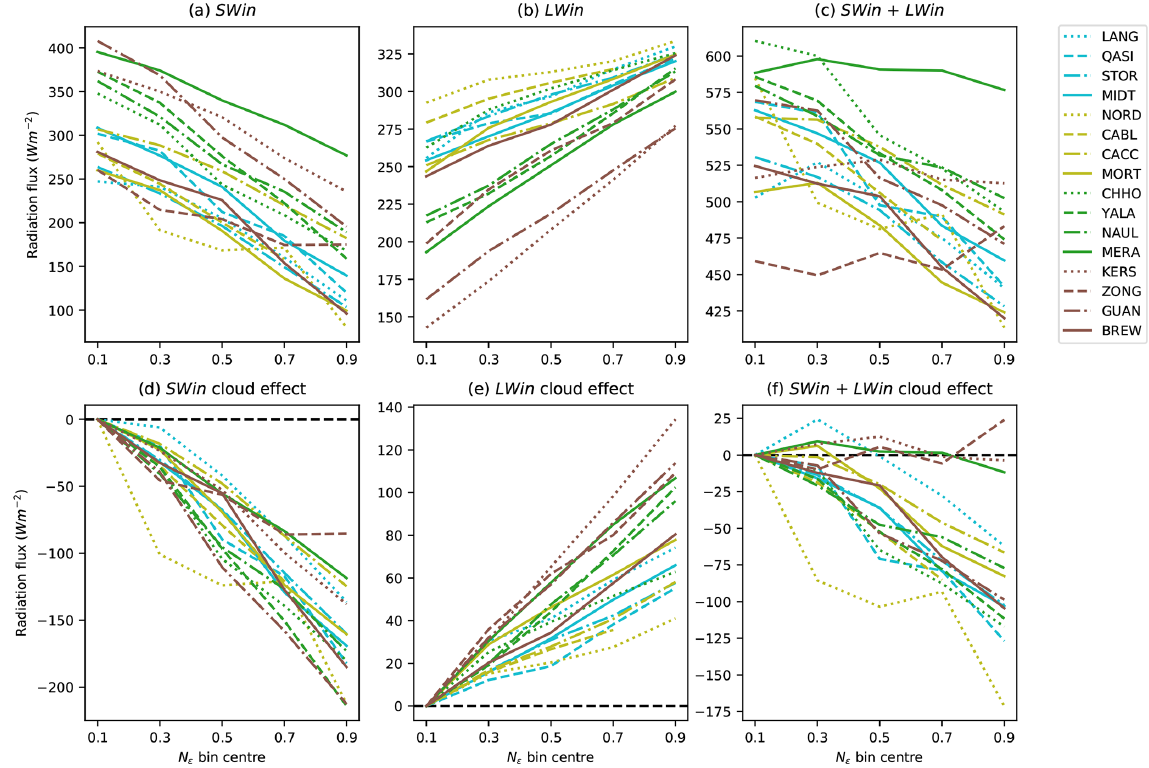
Figure 6. (a–c) Average melt-season incoming radiation fluxes (SWin, LWin) for different daily average cloud conditions ( N ε ). (d–f) As for (a–c) expressed as change from clear-sky conditions ( N ε < = 0 . 2). Note that the y -axis range differs between